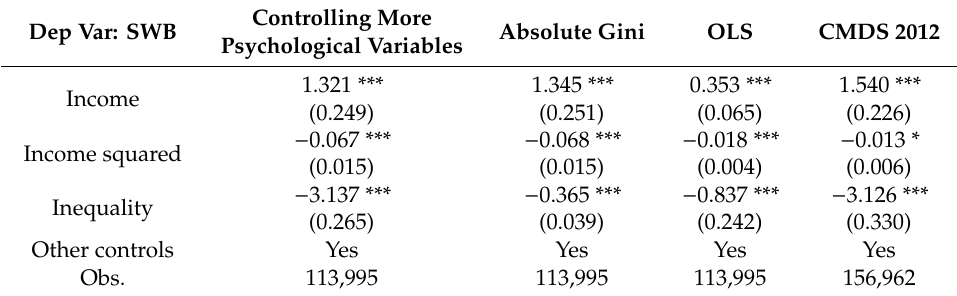
Table 6. Income and inequality e ff ects of migrants: additional